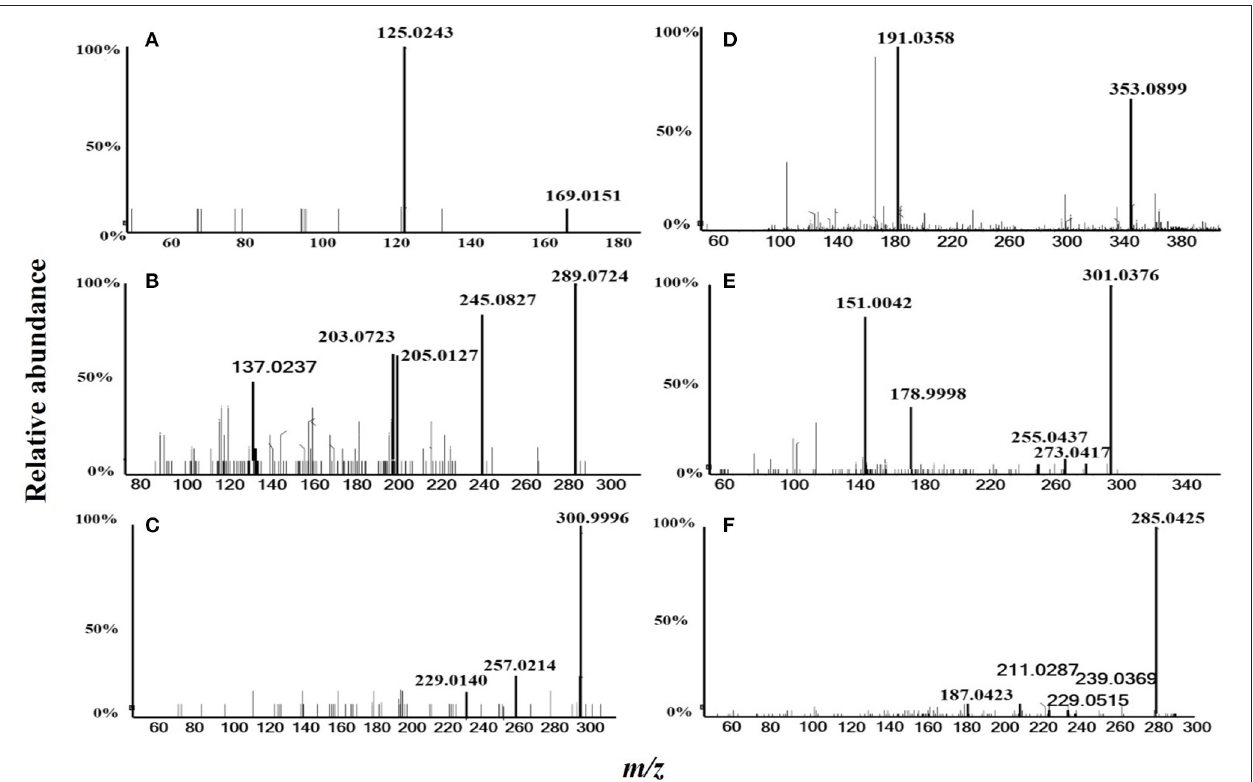
FIGURE 7 | MS/MS spectrometric analysis of the six compounds identified in the dichloromethane fraction of the Camellia nitidissima Chi flowers by HPLC Triple TOF MS/MS. Gallic acid (A) , Catechin (B) , Ellagic acid (C) , Chlorogenic acid (D) , Quercetin (E) , and Kaempferol (F) .